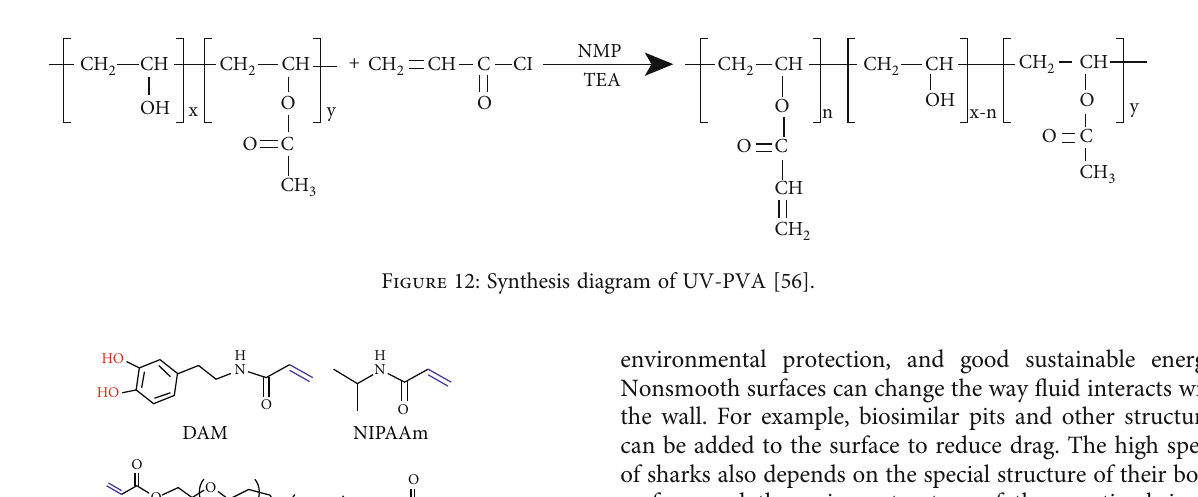
Figure 11: Dimer formed by a dimer connected by disul fi de bonds in the nonglycosylated region [32].